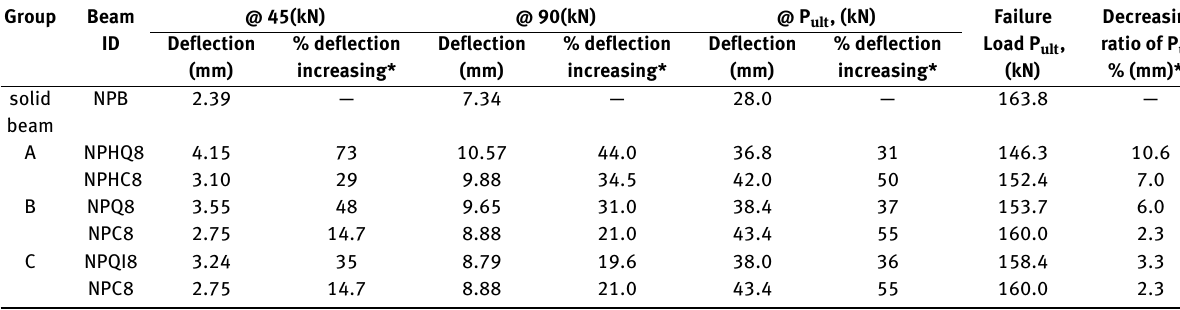
Figure 4: Load versus mid span deflection for non-prismatic beams Table 3: Deflection at various loading stages of the tested beams